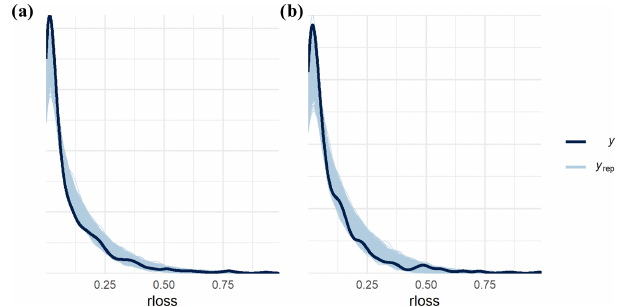
Figure 2. Density plot of observed loss ratio ( y ) and simulations drawn from posterior predictive distribution ( y rep ) over (a) training ( n = 1269) and (b) testing ( n = 543) data with flood-type model.